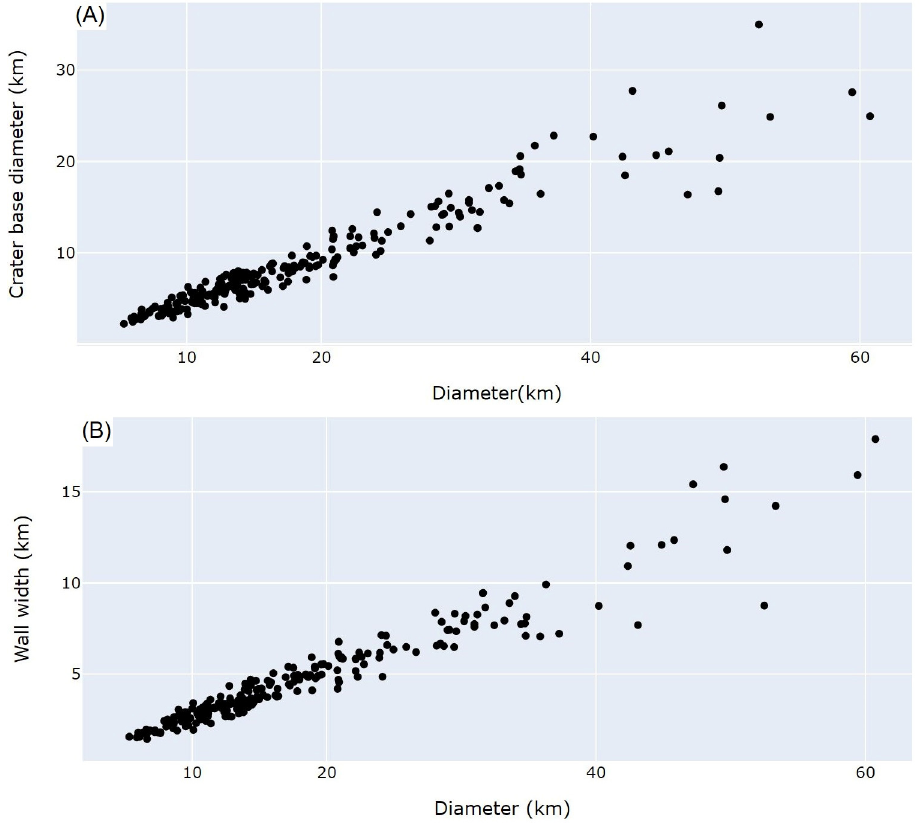
Figure 14. ( A ) Wall width versus diameter. ( B ): Diameter of base versus Diameter. All craters plot- ted.